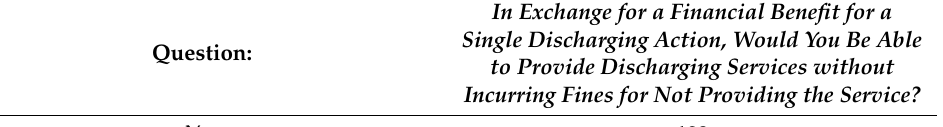
Table A11. Detailed responses to question (18).